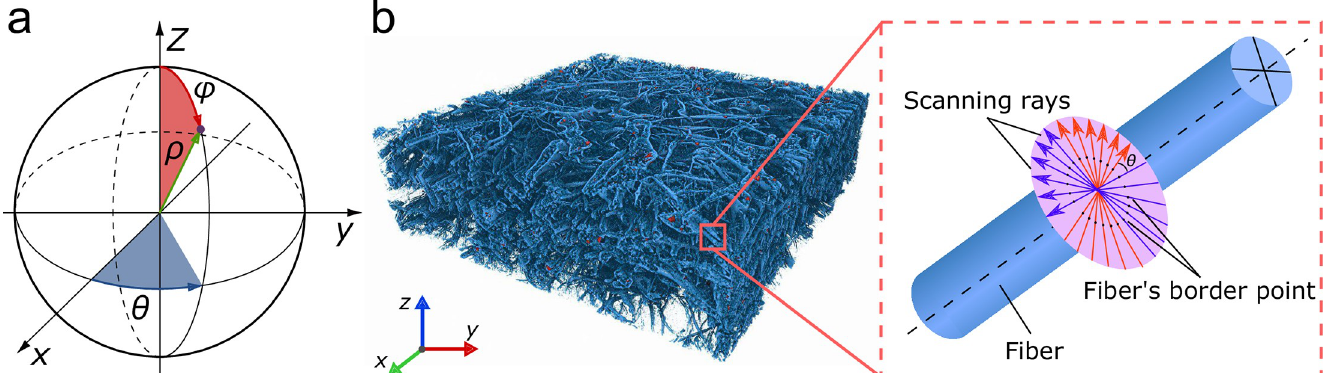
Fig 4. The representation of a fiber in a spherical coordinate system (a). 3D rendering of a rPCL scaffold with SiHA inclusions acquired with micro-CT with a schematic for the diameter estimation algorithm (b).